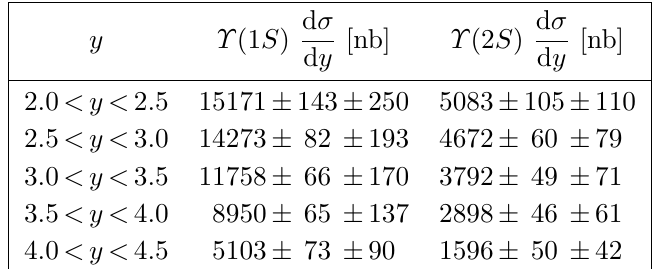
p s = 8 : 16 TeV. The (cid:12)rst uncertainty is NN